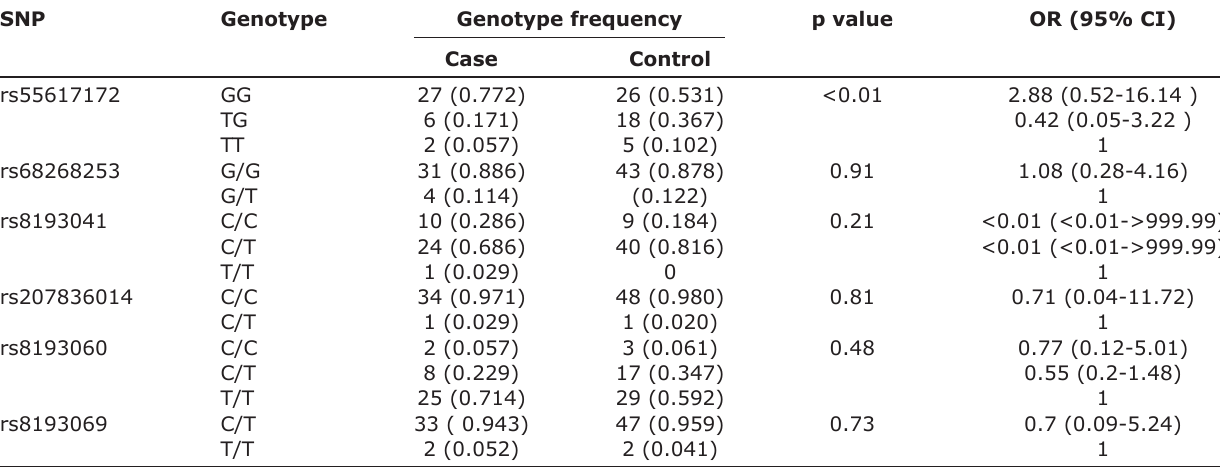
Table-3: Genotype frequency distribution of TLR genes and their association with bTB. SNP